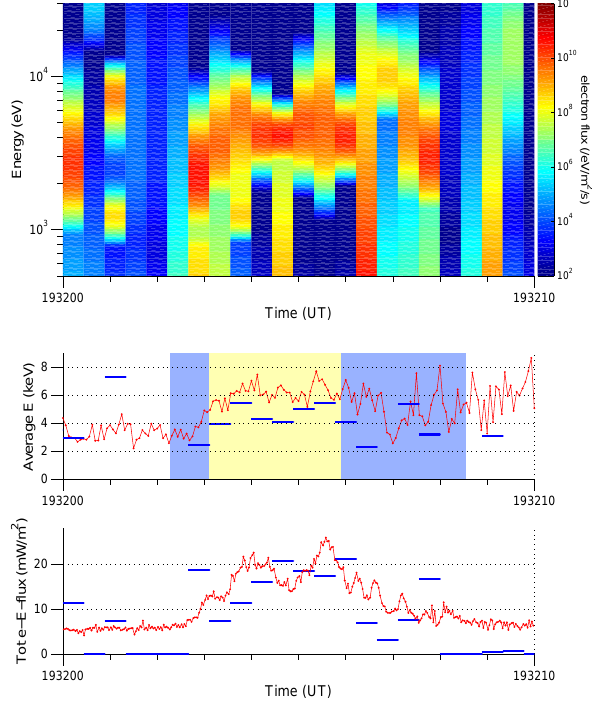
Fig. 8. Top: Electron energy and flux spectrogram from the inver- Fig. 8. Top: electron energy and flux spectrogram from the inver- sion model, for the arc at 19:32 UT. Middle: Average energy as a sion model, for the arc at 19:32UT. Middle: Average energy as a function of time derived from the model (blue bars) and from ASK function of time derived from the model (blue bars) and from ASK emission ratios (red). Blue shaded regions are the time intervals the emission ratios (red). Blue shaded regions are the time intervals the arc is moving into and out of the radar beam. The yellow shade is arc is moving into and out of the radar beam. The yellow shade is the time interval when the arc was located in the centre of the beam. the time interval when the arc was located in the centre of the beam. Bottom: Total electron energy flux as a function of time, from the Bottom: total electron energy flux as a function of time, from the inversion model (blue bars) and the ASK data (red). inversion model (blue bars) and the ASK data